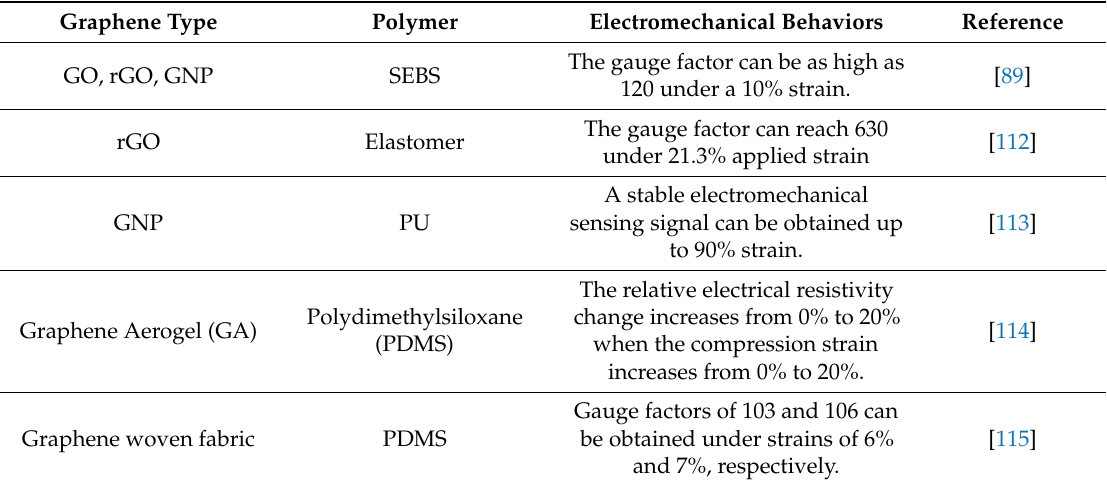
Table 3. Electromechanical behaviors of